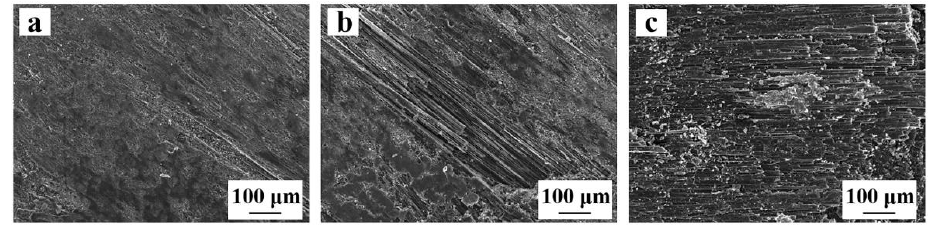
Figure 7. Worn surfaces of the three brake discs after wear test: ( a ) test brake disc; ( b ) commercial brake disc 1; ( c ) commercial brake disc 2.